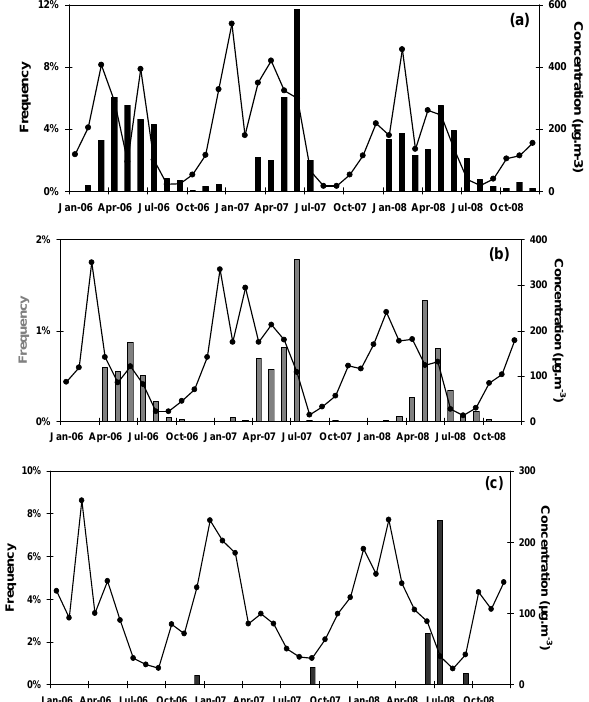
Fig. 7. Monthly frequency of high wind speeds (black bars : > 7ms − 1 ; grey bars : > 6ms − 1 ) and monthly mean concentration of dust (black line with black circles) in Banizoumbou (a) , Cinzana (b) and M’Bour (c) from January 2006 to December